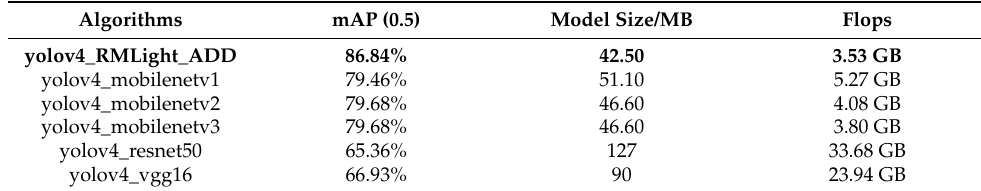
Table 5. The experimental results for improving the effectiveness of the backbone feature extrac- tion network.